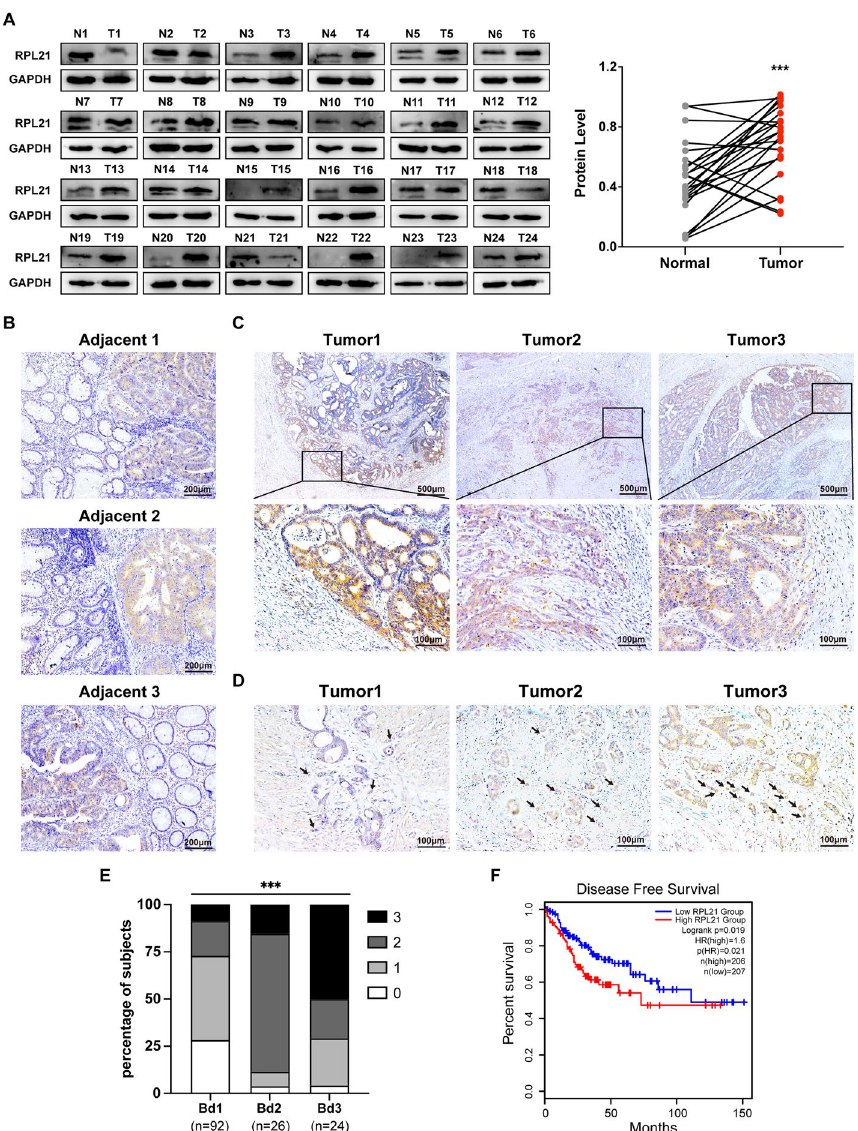
Fig. 1 RPL21 is upregulated in CRC tissues, correlating with tumor invasiveness and patient survival rate. A RPL21 protein expression in human CRC tissues (T) and paired adjacent normal tissues (N) was detected by western blotting. The quantification of the protein level was normalized to that of GAPDH. n 24, *** p < 0.001, paired Student’s t -test. B The representative images of the RPL21 expression in 142 = paraffin-embedded human CRC tissues with adjacent normal colorectal tissues (adjacent 1, adjacent 2, and adjacent 3) detected by IHC staining (scale, 200 μm). C The representative images of RPL21 expression in the invasive front of CRC (tumor 1, tumor 2, and tumor 3) were detected by IHC staining (scale, 500 μm, 100 μm). D The representative images of RPL21 expression in CRC tumor buds (tumor 1, tumor 2, and tumor 3) were detected by IHC staining (scale, 100 μm). The arrowheads indicate the tumor buds. E The correlation between the scores of RPL21 expression in tumor buds and the grades of tumor budding. n Kendall’s Tau test. F Kaplan–Meier survival analysis of CRC patients with high or low expression of RPL21. n =